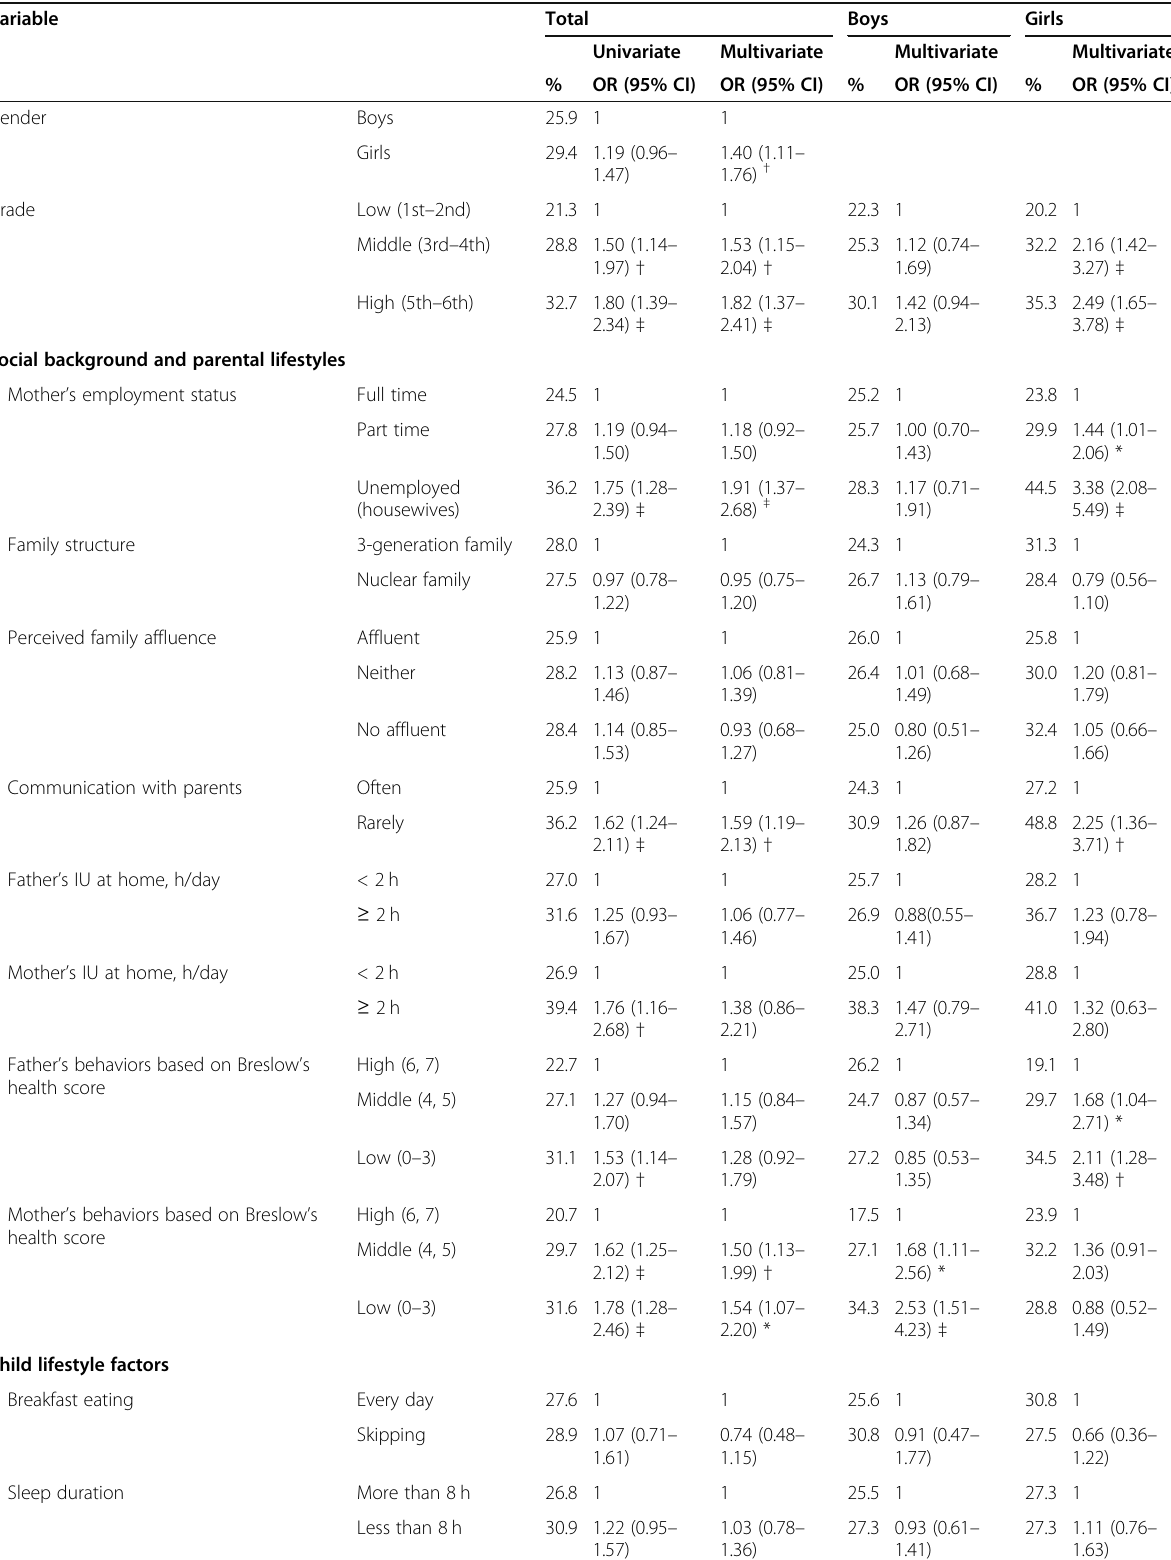
Table 3 Logistic regression analysis results for “ Lack of physical activity ” ( n =